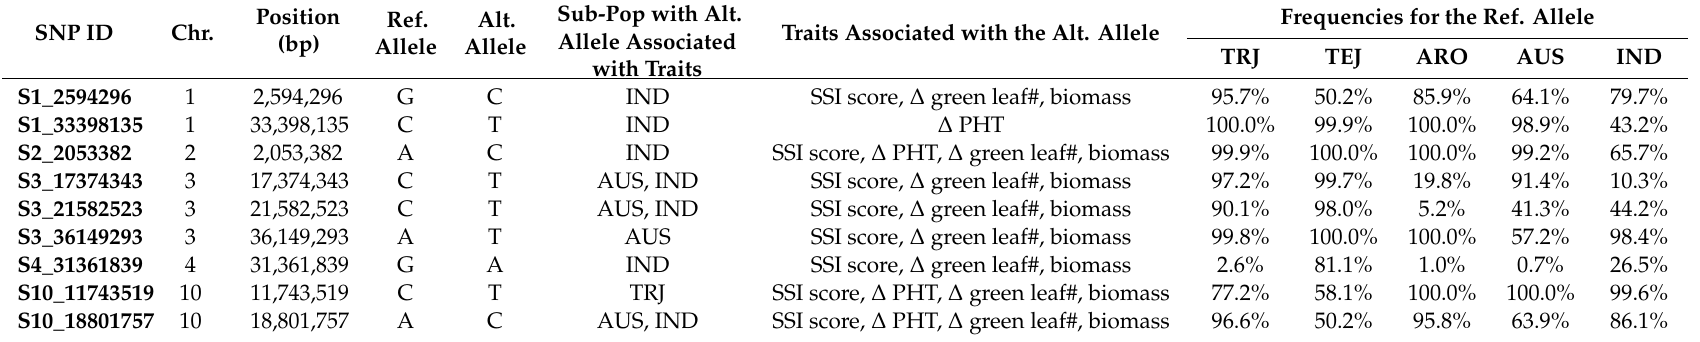
Table 3. GWAS analysis of USDA rice mini-core accessions: ( a ) Representative SNP locations with reference (Ref.) or alternate (Alt.) allele associated with salt-tolerant traits in specific subpopulations of the USDA rice mini-core collection, and subpopulation SNP allele frequencies across 3000 rice genomes; ( b ) Significant SNP e ff ects in each subpopulation as estimated by ANOVA. Sub-Pop with Alt. Frequencies for the Ref. Traits Associated with the Alt. Allele Allele Associated with Traits